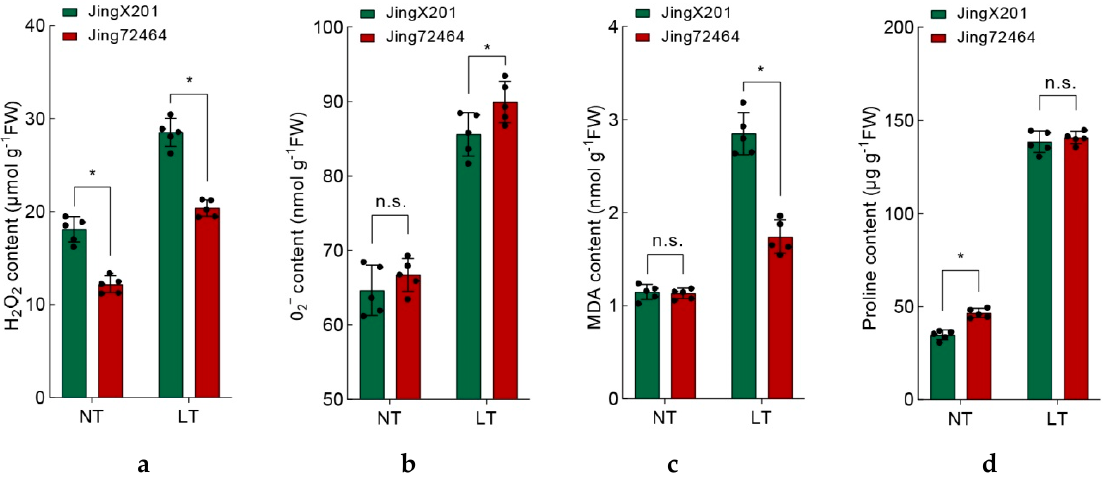
Figure 3. Ameliorated oxidative stress in LT-tolerant inbred accession. ( a ) Superoxide content in LT-sensitive inbred JingX201 and LT-tolerant inbred Jing72464 under NT and LT condition. ( b ) Hydrogen peroxide content. ( c ) MDA content. ( d ) Proline content. ( a to d ) Data are mean ± s.e.m. ( n = 5). n.s. means no significance, * means p < 0.05.